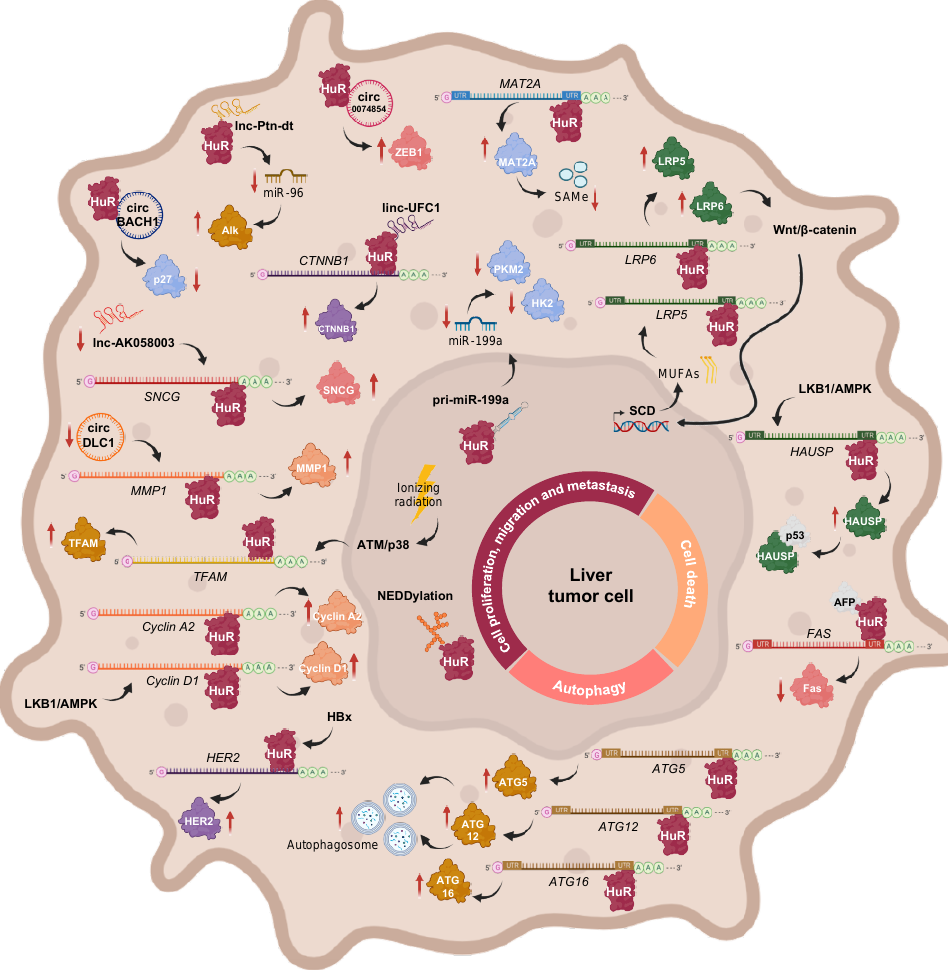
Figure 2. Main regulatory axes involving HuR, which are associated with cell proliferation, invasion, metastasis, apoptosis, and autophagy during HCC. These include the transcriptional, post-transcriptional, and post-translational modulators of HuR function, in addition to HuR target transcripts.